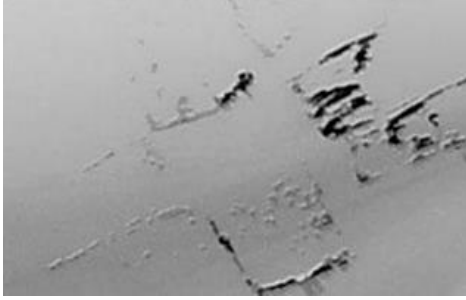
Figure 6. The result of conversion to grayscale.